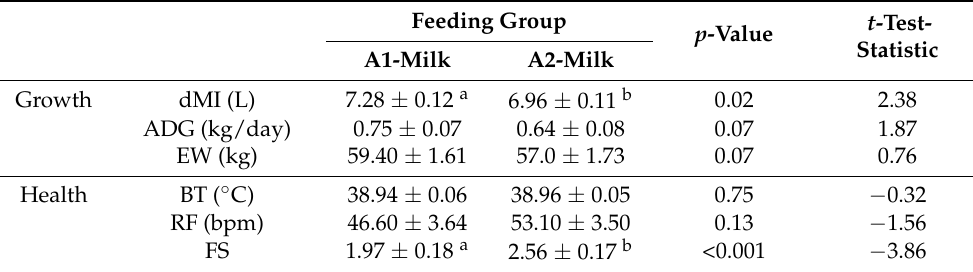
Table 3. Least squares means with corresponding standard errors ( ± SE), and t -test-statistic for milk intake, growth, and health parameters of calves receiving either A1-milk or A2-milk.